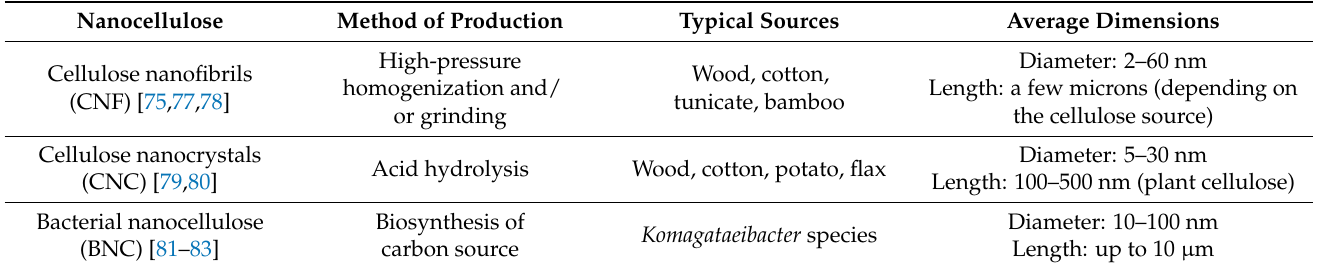
Table 1. Classes of nanocellulose type, production methods, sources, and its average